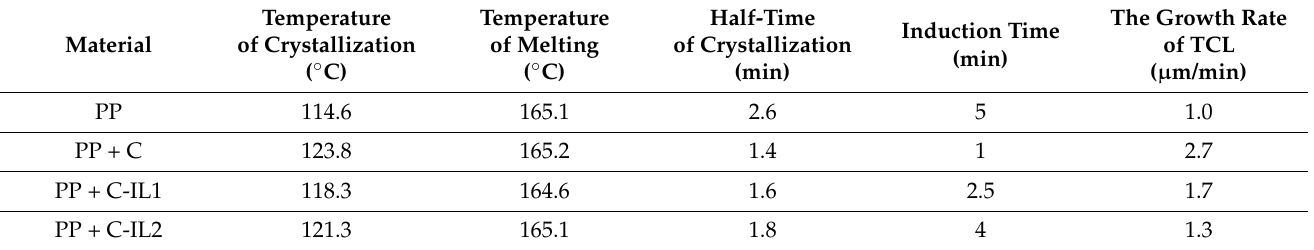
Figure 6. DSC thermograms of crystallization processes for polypropylene matrix and nanocomposites. Table 1. The determined kinetic parameters (crystallization temperature (T c ), melting temperature (T m ) and half-time of crystallization (t 0.5 ) and PLM analysis data (induction time and the growth rate of TCL) for the analyzed